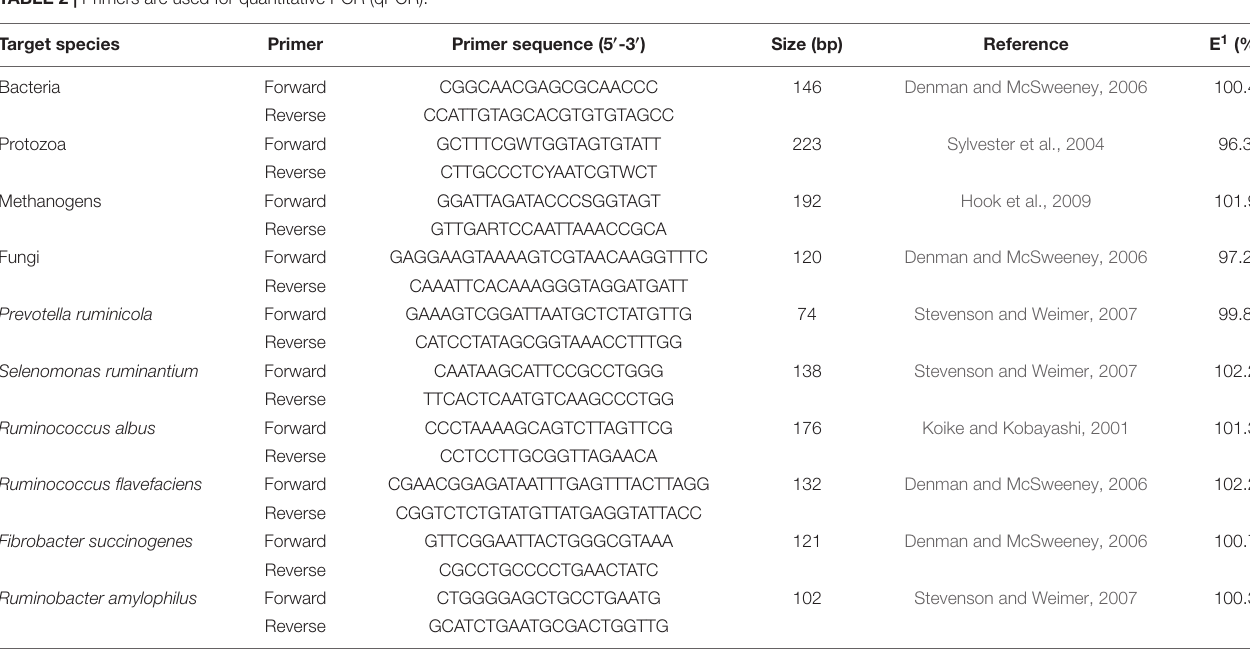
FIGURE 1 | A schematic diagram of gut regions of goat. The sampled regions of the gut are highlighted in black boxes. TABLE 2 | Primers are used for quantitative PCR